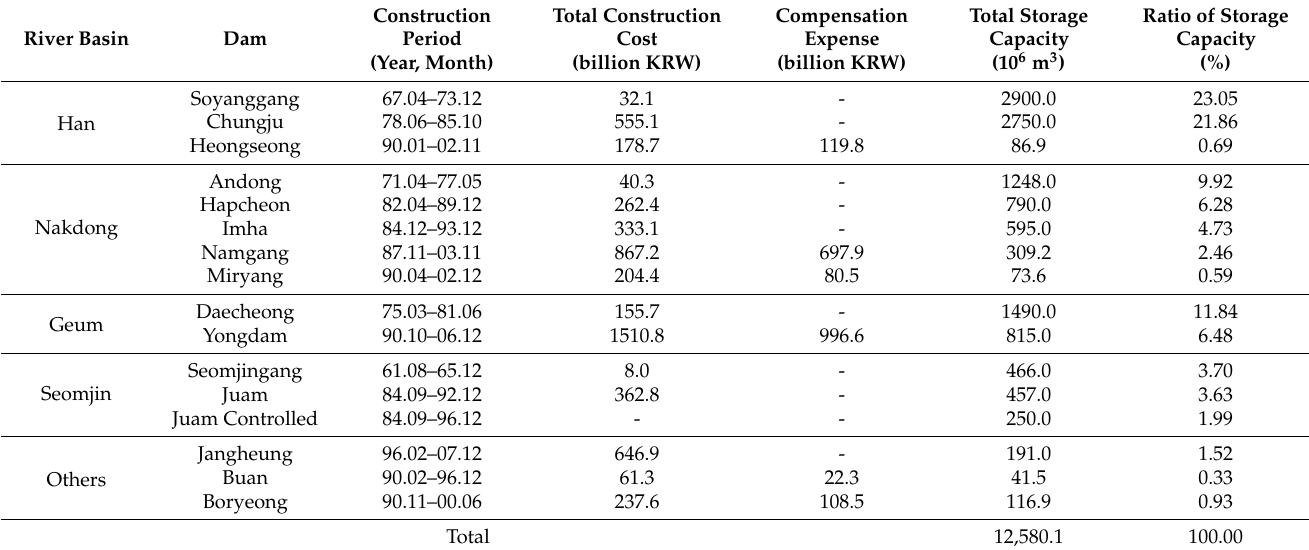
Table 1. Total construction cost and storage characteristics of multipurpose dams in